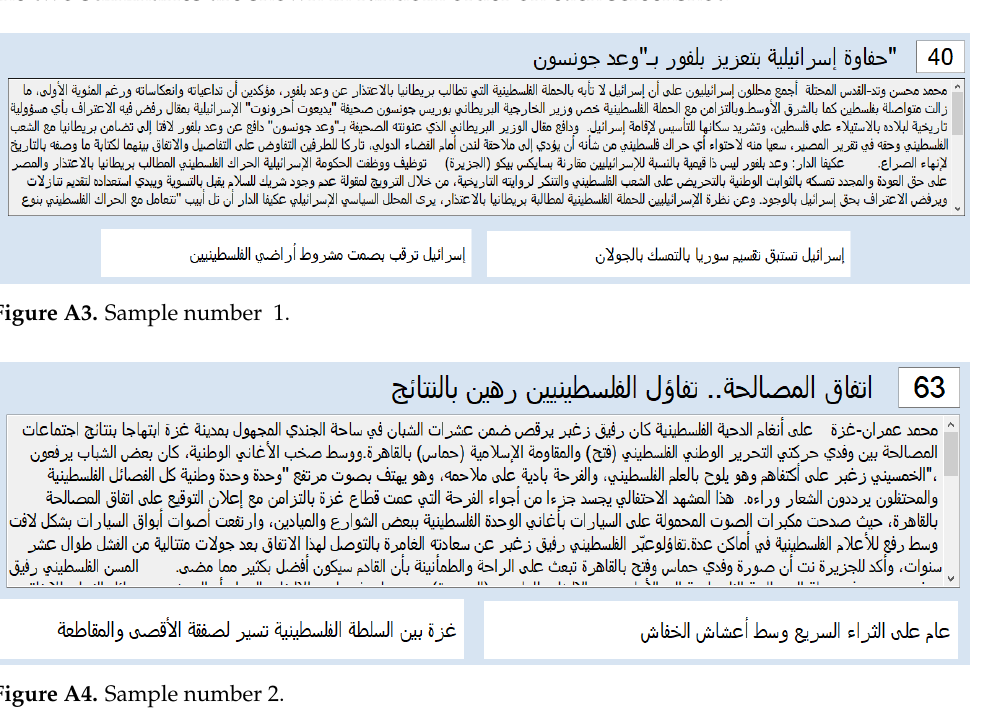
Figure A4. Sample number